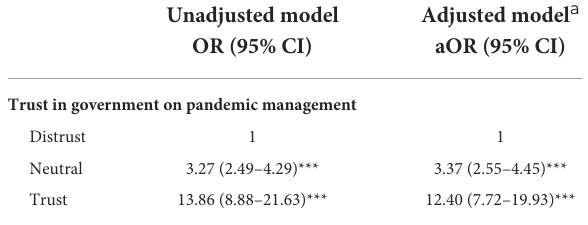
TABLE 2 Multivariable ordinal logistic regression on predictors of the willingness to receive the COVID-19 vaccine ( n =